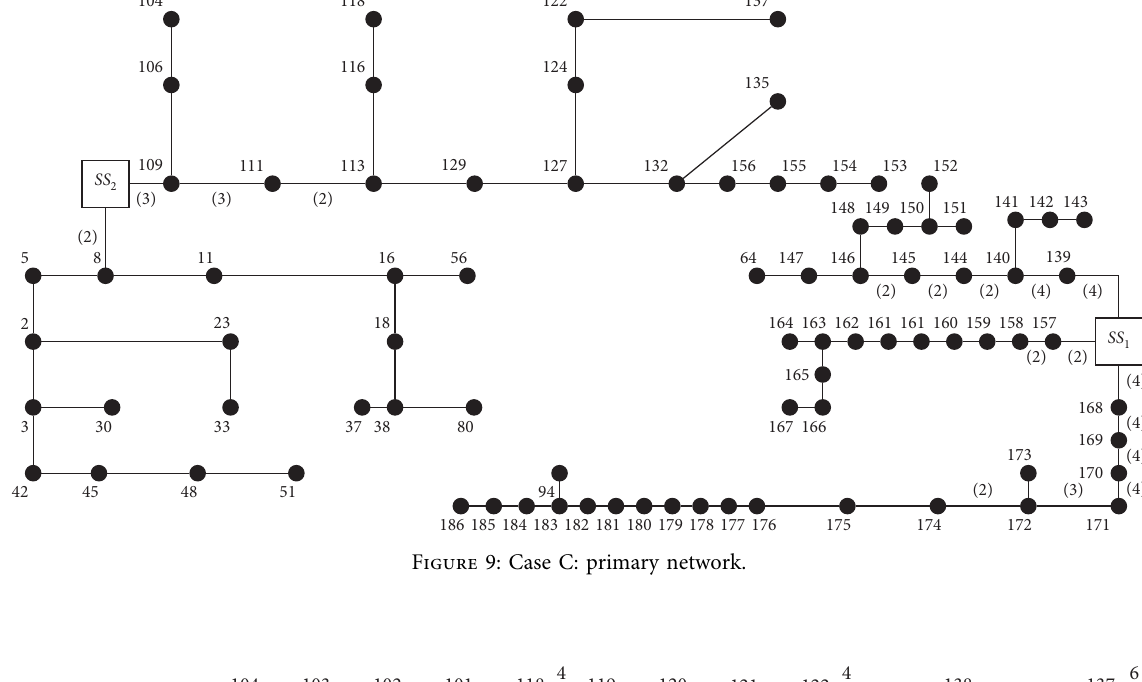
Figure 9: Case C: primary network.